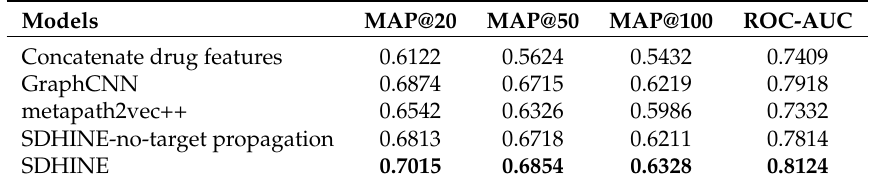
Table 5. DDI occurrence identification performance